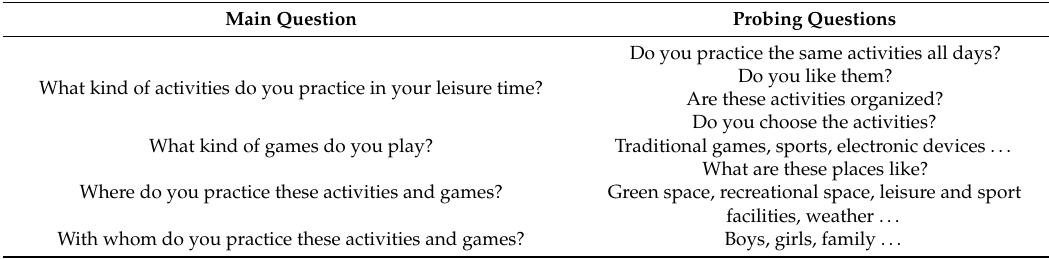
Table 2. Focus group